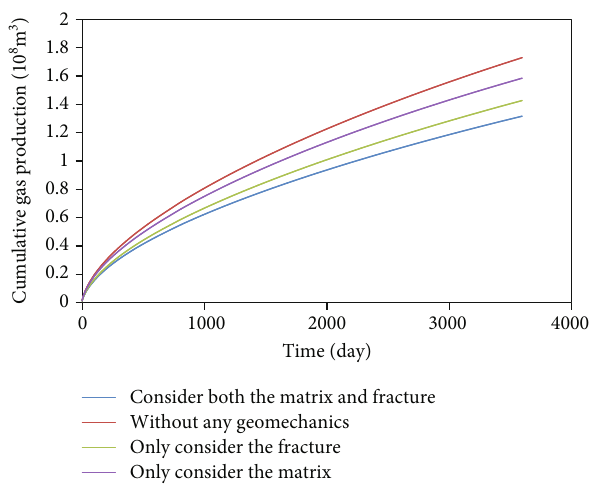
Figure 9: E ff ects of matrix and fracture stress sensitivity on cumulative